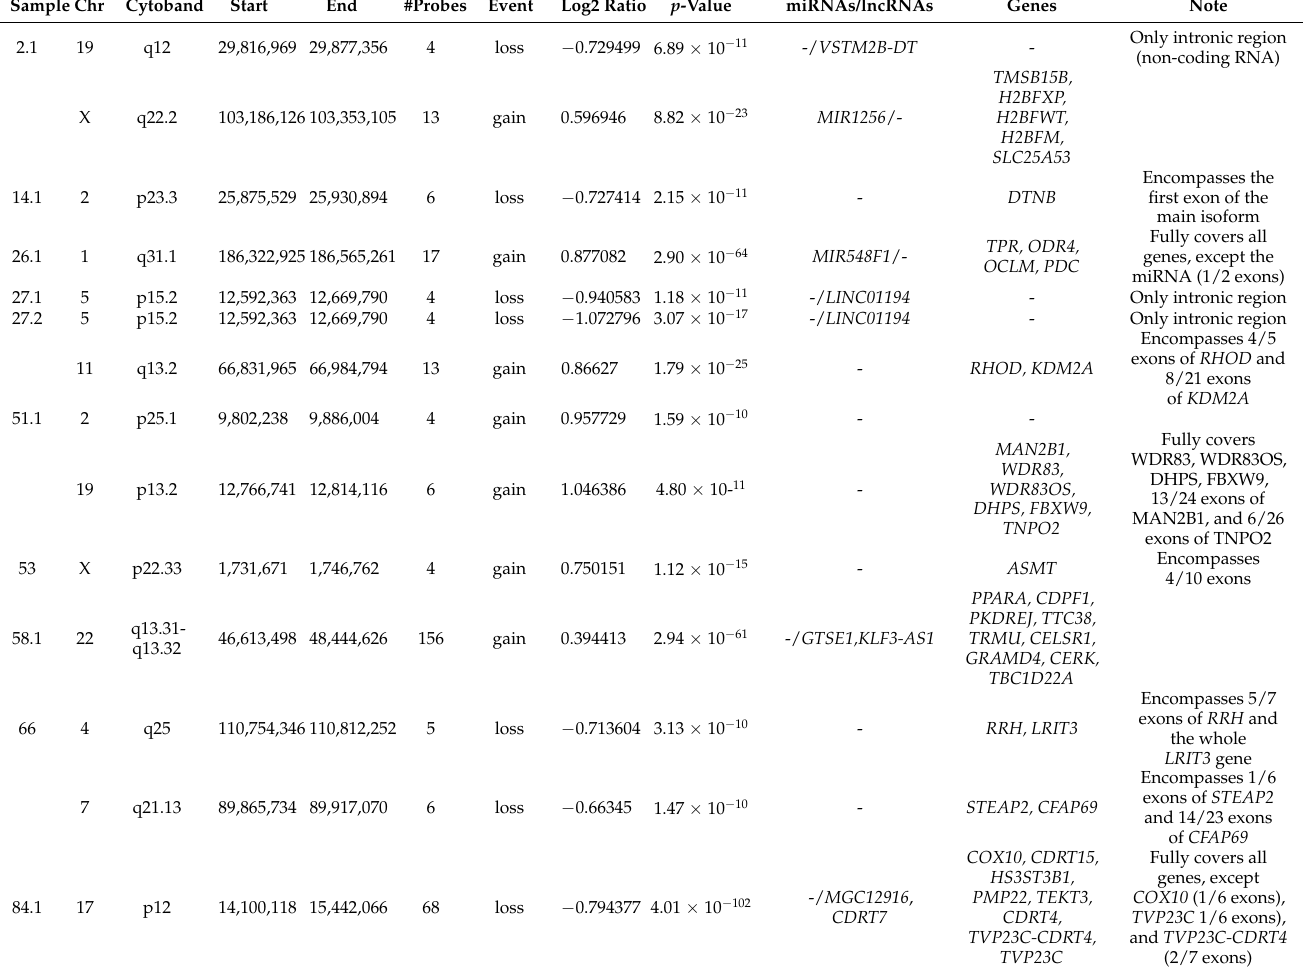
Table 3. Rare germline copy number alterations detected in the blood samples of 14 out of 18